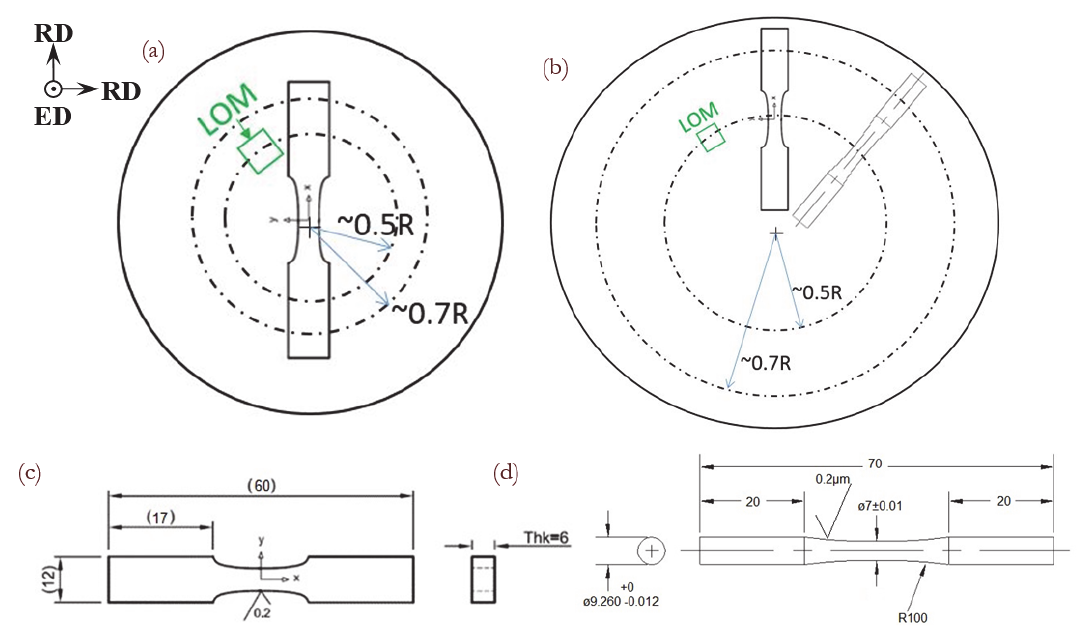
Figure 1: Schematic diagram for sample preparation and extraction. (a) As-extruded billet (b) Forged billet (c) tensile specimen (d) fatigue specimen. All dimensions in mm, Light Optical Microscopy (LOM) specimens taken from a position of